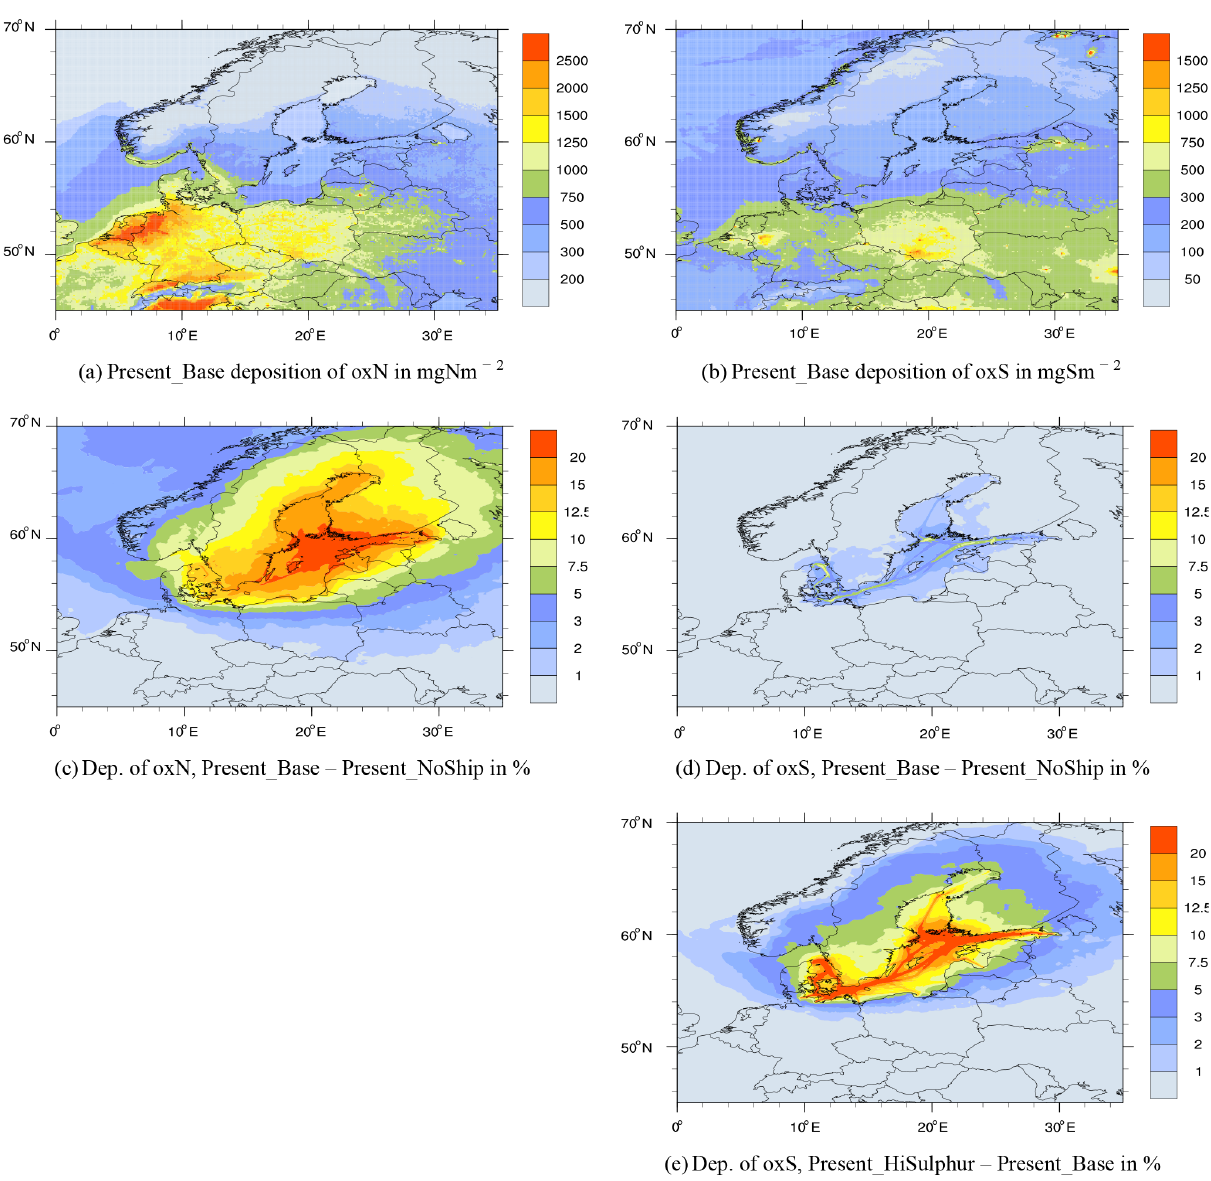
Figure 2. (a, b) Calculated depositions of oxidised nitrogen and sulfur. (c, d) Present percentage contributions from BAS ship emissions to depositions of oxidised nitrogen and oxidised sulfur with reference to Base 2016. (e) Percentage contribution to depositions of oxidised sulfur with reference to 2014 BAS